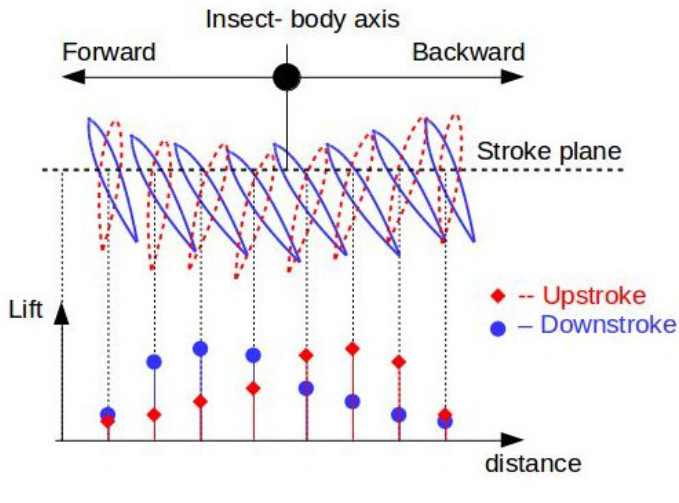
Figure 4. Avian’s lift generation process.